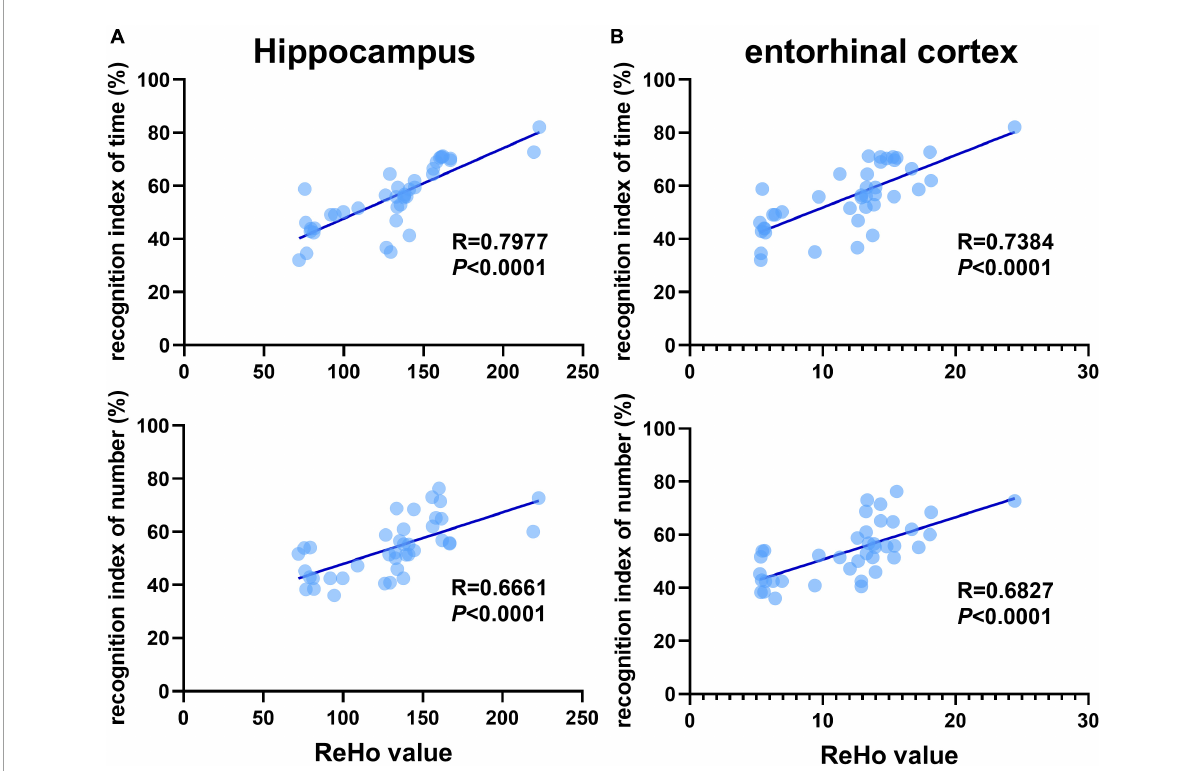
FIGURE5 Recognition memory is correlated with aberrant ReHo across the hippocampus and entorhinal cortex. Correlational analysis between the recognition indexes (time/number) and ReHo value obtained from the (A) hippocampus, (B) entorhinal cortex ( n = 10 in each group).